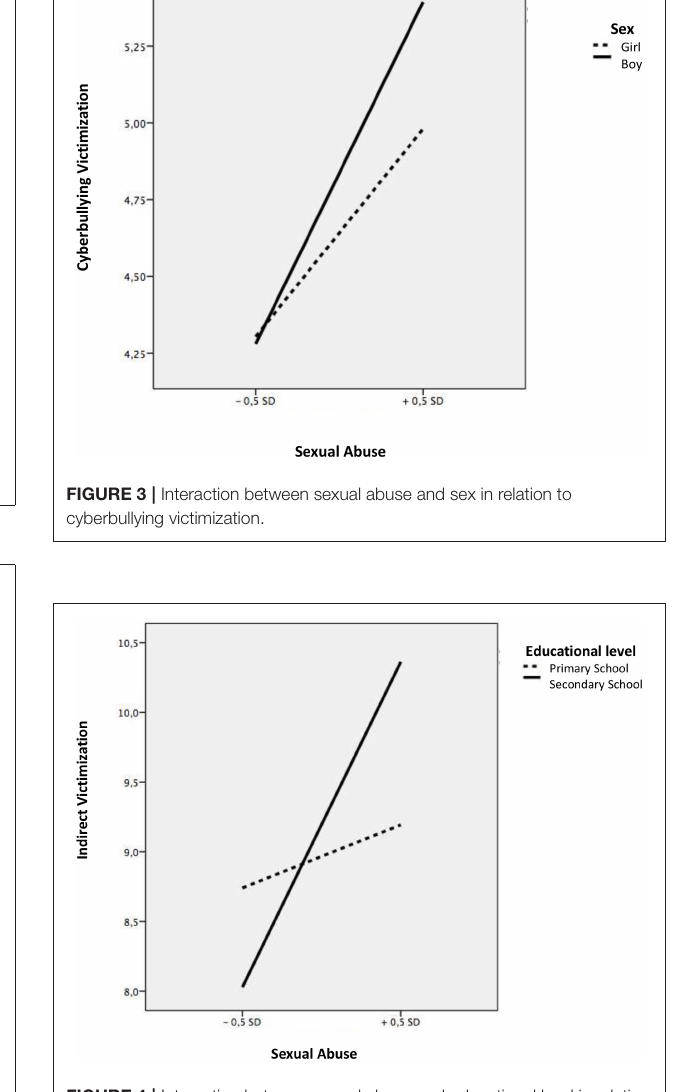
FIGURE 4 | Interaction between sexual abuse and educational level in relation to indirect